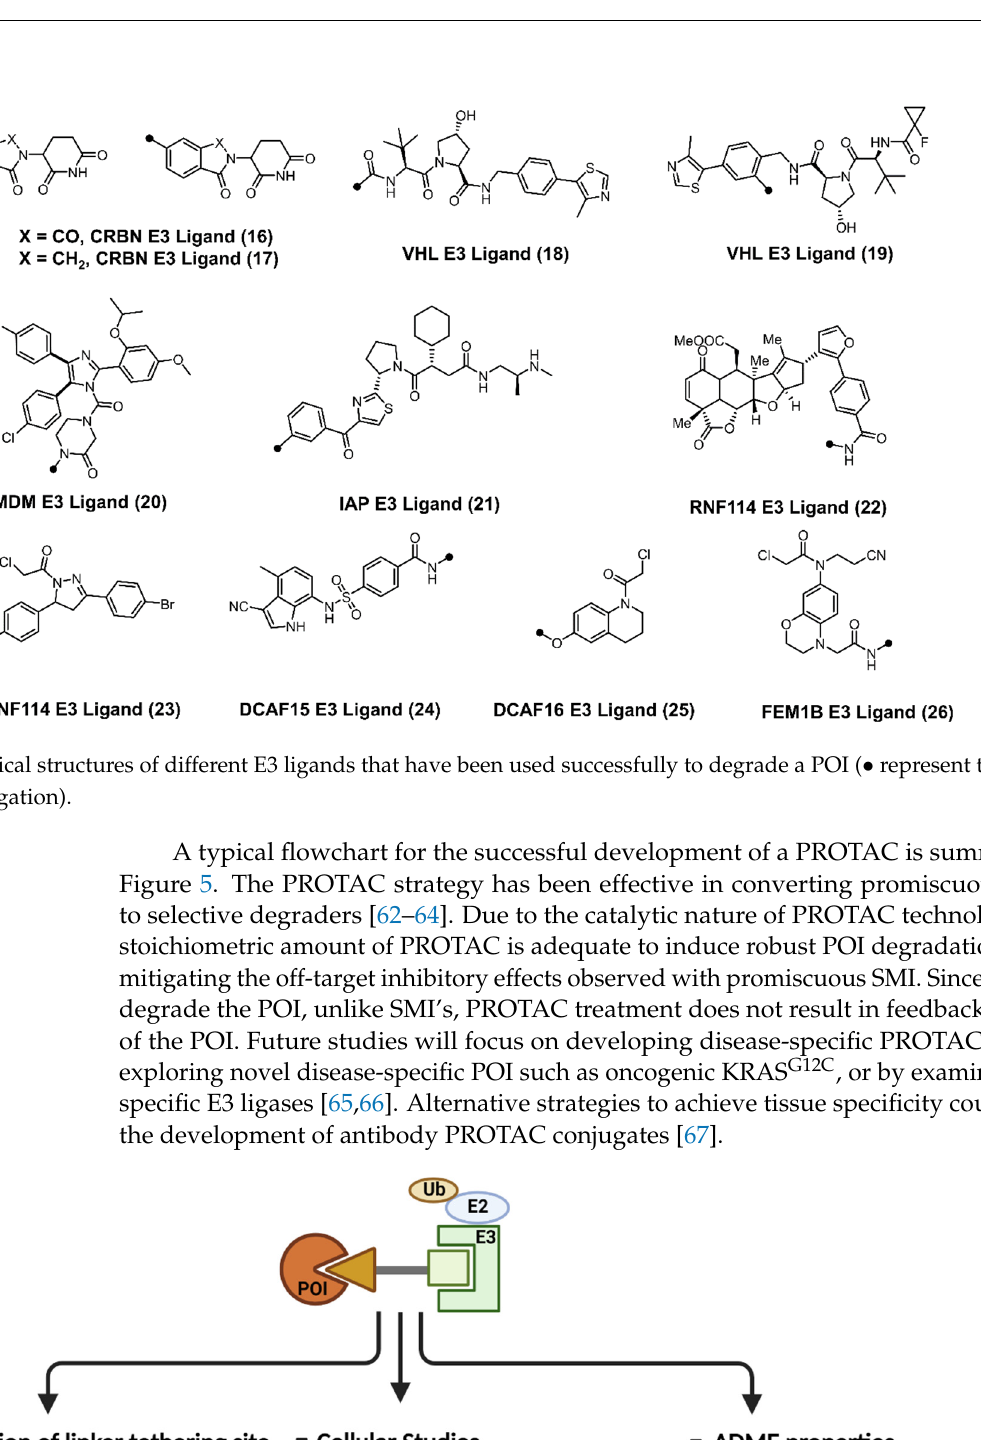
Figure 5. A flowchart highlighting the development of a PROTAC (created with BioRender.com).